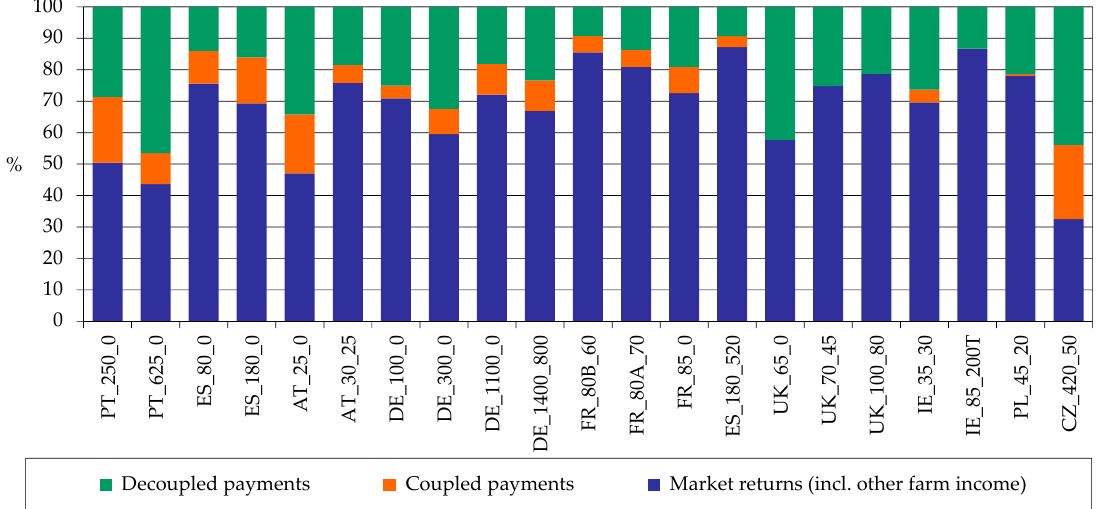
Figure 12. Composition of whole farm returns (%). Source: model results.